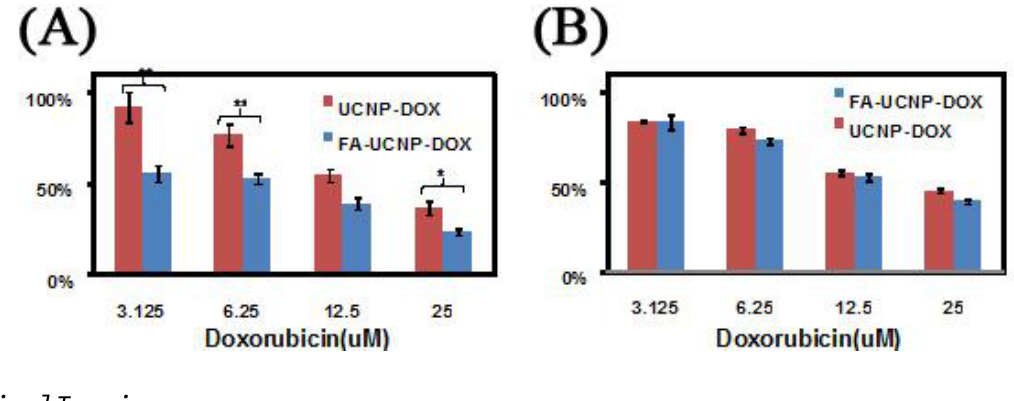
Figure 15. Cell viability data of FR positive KB cells ( A ) and negative HeLa cells ( B ) treated with FA-UCNP-DOX and UCNP-DOX ([63], reproduced by permission of